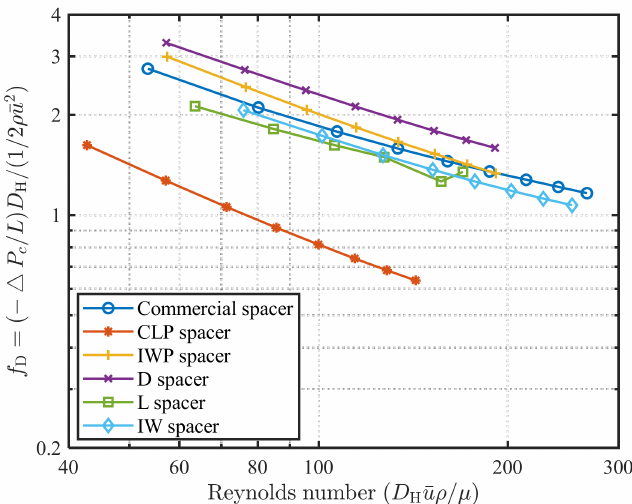
Figure 10. Comparison of Darcy friction coefficient vs. Reynolds number relationships for Com- mercial, CLP, IWP, D, L, and IW spacer-filled channels obtained using 3D simulations. Re is based on D H